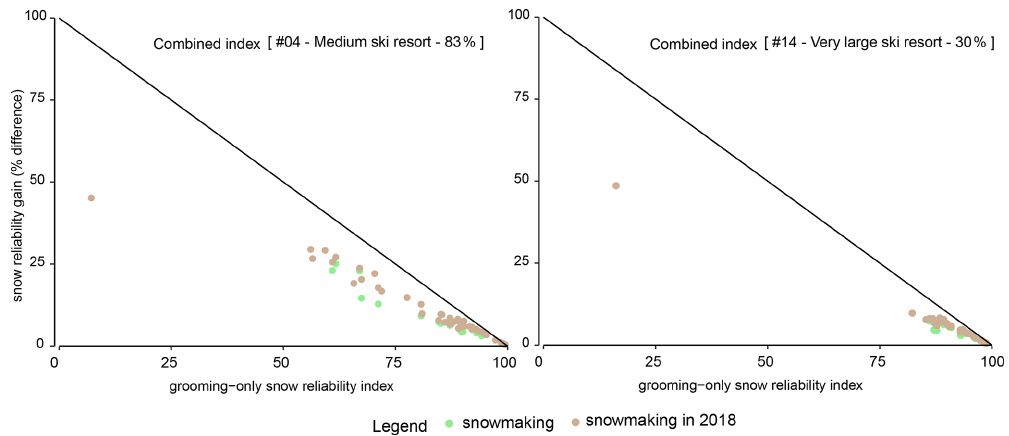
Figure 4. Relationship between the combined snow cover reliability difference ( y axis) between configurations with snowmaking and the snow cover reliability with grooming only (no snowmaking, x axis), for two contrasting ski resorts.